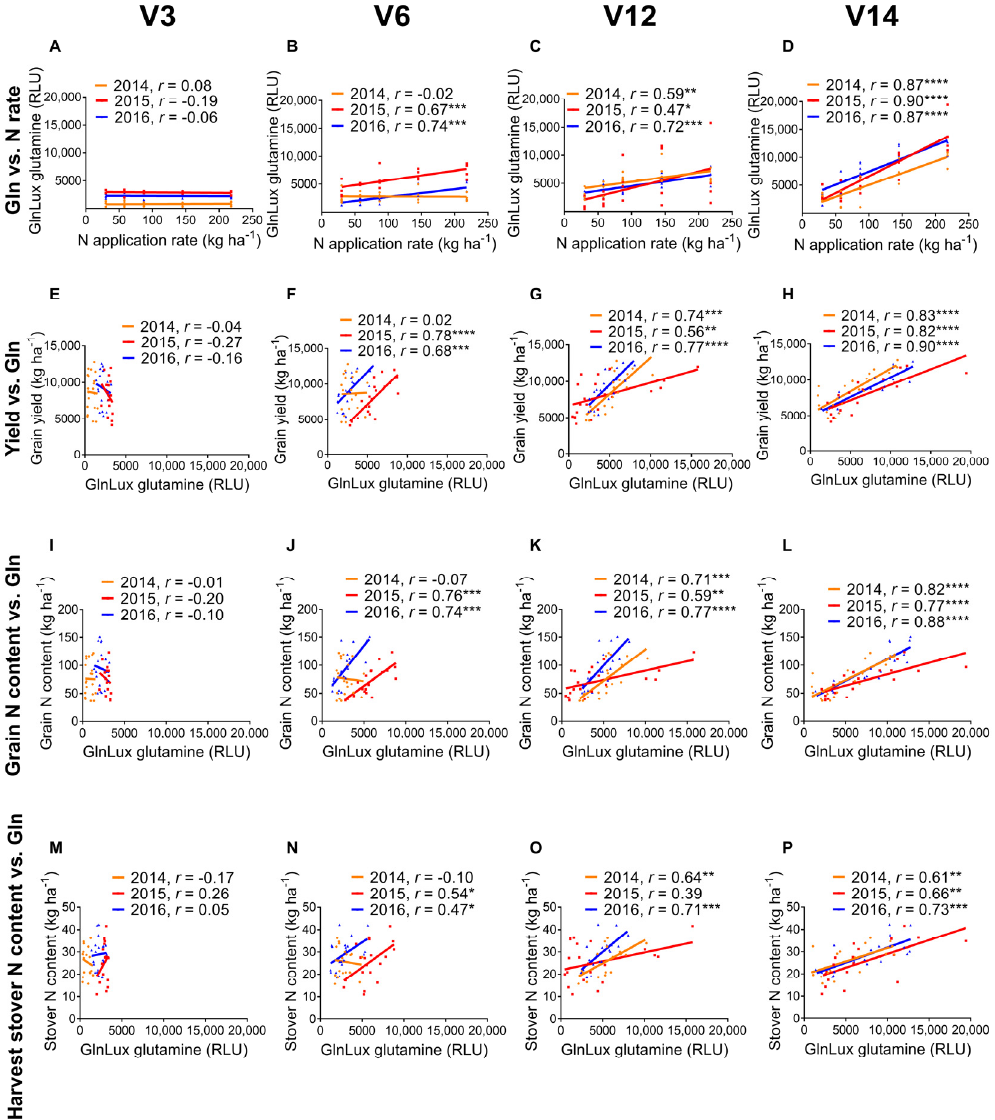
Figure 1. GlnLux glutamine values from maize leaf tissue displays increasing correlation with end ‐ season measurements as vegetative growth stage (V3 to V14) progresses. Pearson correlation of GlnLux glutamine levels was performed against ( A – D ) N application rate; ( E – H ) grain yield; ( I – L ) grain N content and ( M – P ) end ‐ season stover N content. One, two, three, and four asterisks beside correlation coefficients of each year represent significance at p < 0.05, 0.01, 0.001, and 0.0001 respectively. RLU, relative light units intercepted by the luminometer in a one second